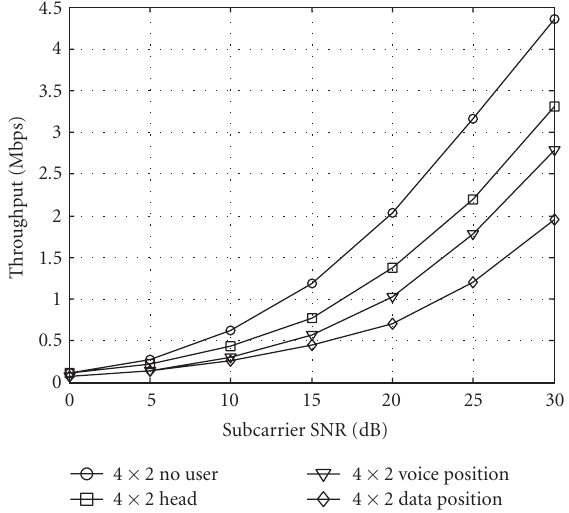
Figure 15: Link throughput in di ff erent usage scenarios for a 4 × 2 MIMO system with spatial multiplexing.